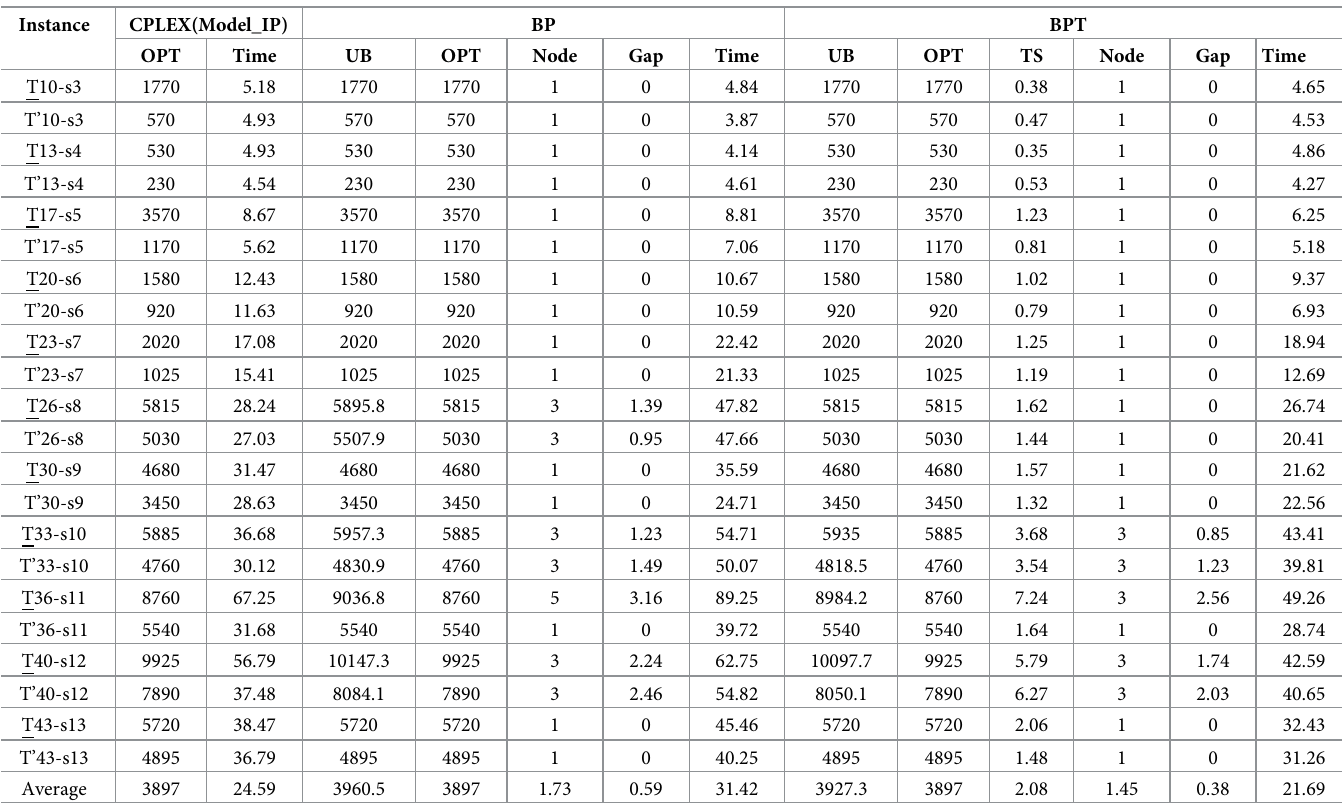
Table 10. The impact of reducing task